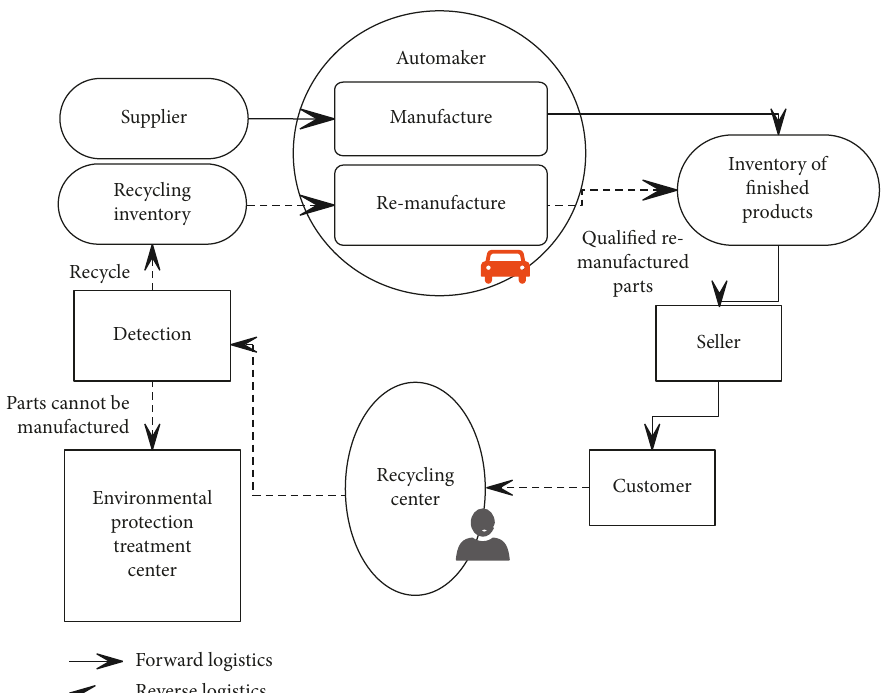
Figure 6: The framework of the automobile reverse logistics inventory control